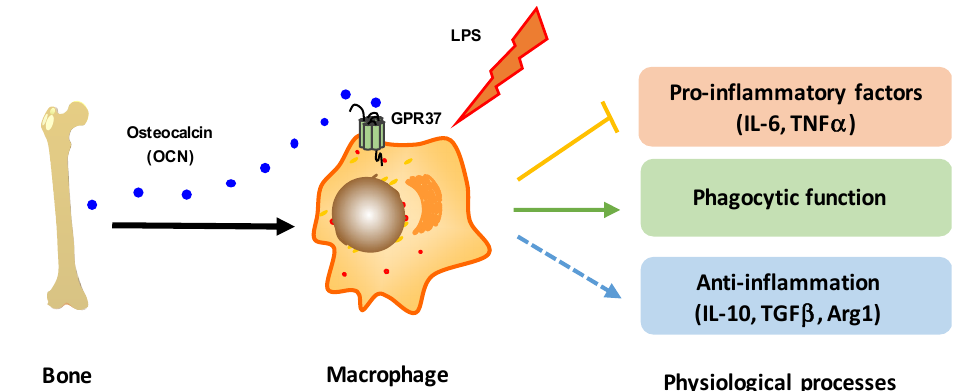
Figure 8. A schematic diagram illustrating that the bone-derived hormone OCN, via the activation of GPR37 in macrophages, plays a protective function against LPS challenge through the regulation of macrophage inflammatory reactions and phagocytic function.